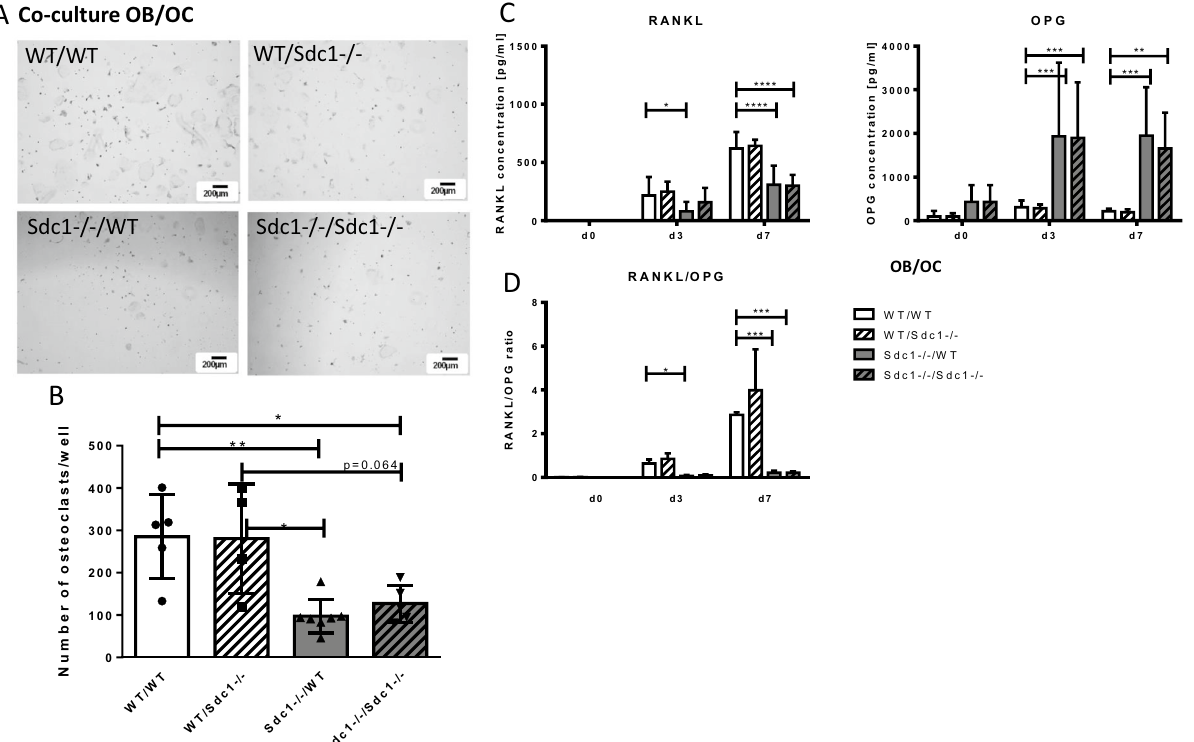
Figure 4. Osteoclast differentiation and RANKL/OPG release in co-cultures of osteoblasts and osteoclasts using Syndecan-1 deficient cells. ( A,B ) Primary osteoblast and osteoclast precursor cells were cultured together in DM + -medium for up to 7 days. Different combinations of genotypes (WT/ Sdc1−/−) as depicted were used (OB/OC). After 7 days, the osteoblast layer was removed by pulling and TRAP staining was performed, representative images are shown ( A , scale bar 200 µm). Osteoclast number was determined as TRAP positive, multinucleated cells ( B ), Experiments were performed four or more independent replicates, data represent means ± SD, Mann–Whitney- U test, * p < 0.05, ** p < 0.01. ( C ) RANKL and OPG concentrations were determined in cell culture supernatant using ELISA. ( D ) RANKL/OPG ratio was calculated. Experiments were